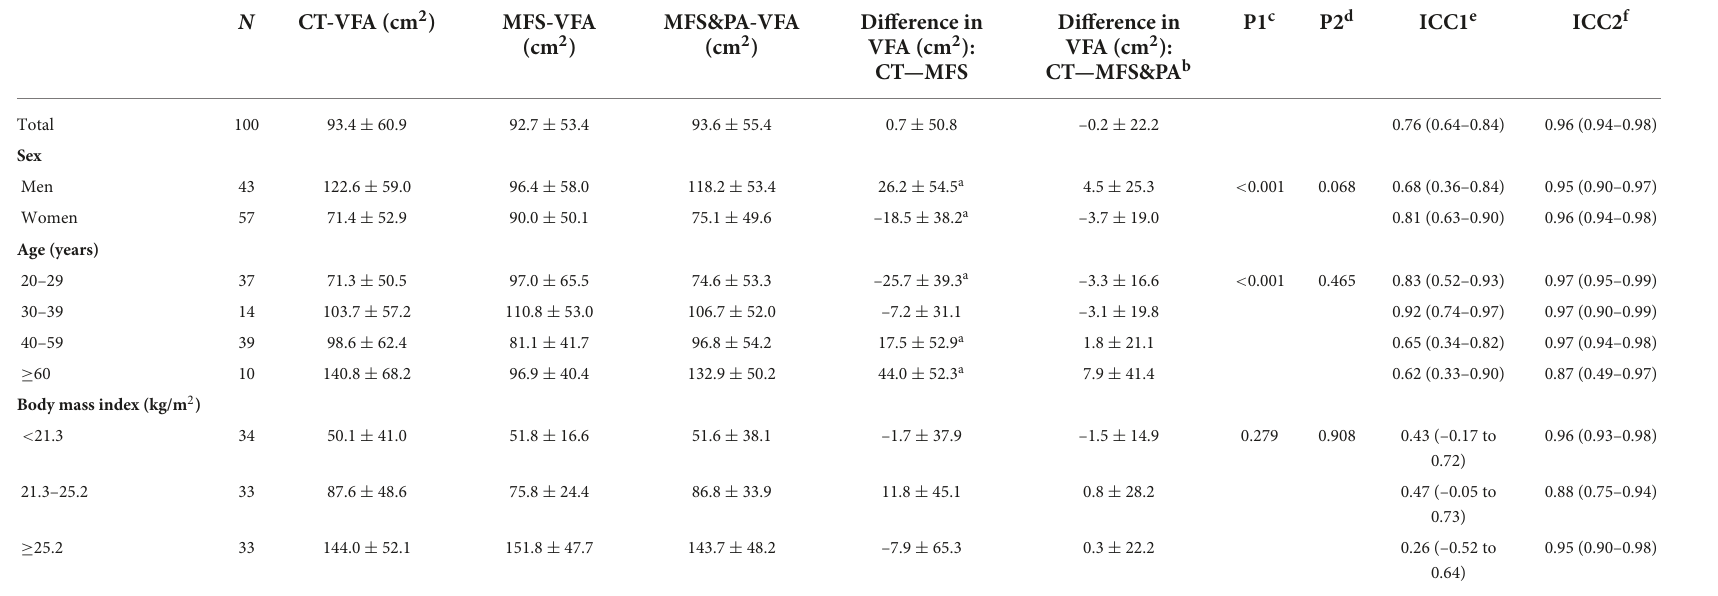
TABLE 2 Subgroup analyses of mean differences for visceral fat